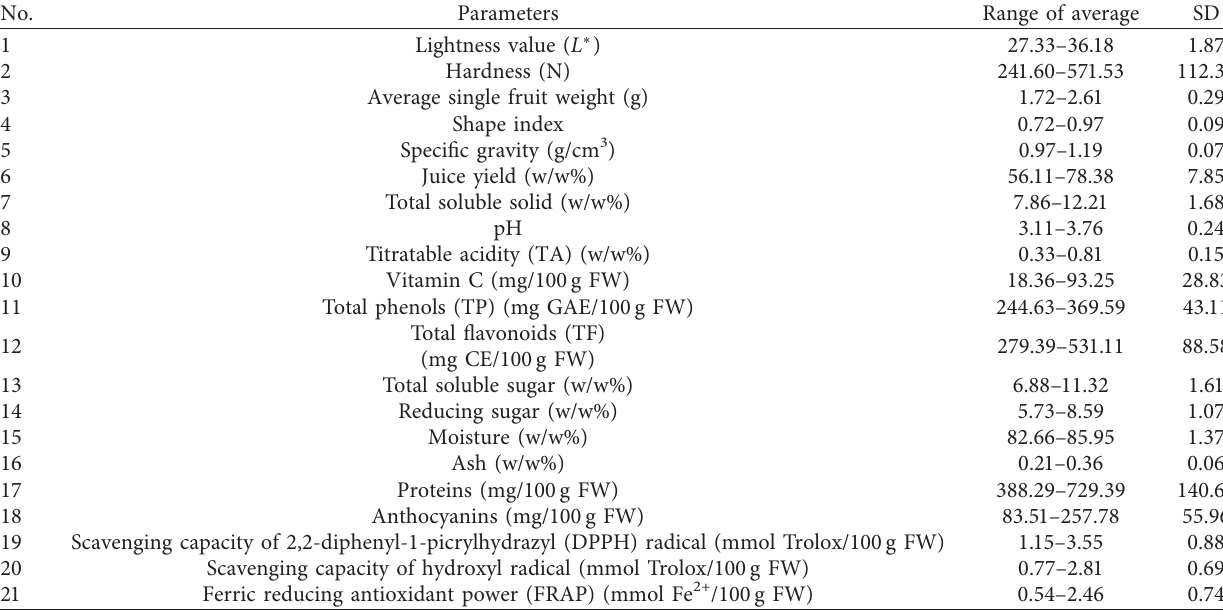
Table 3: Ranges of quality parameters of blueberry fruits of different cultivars.